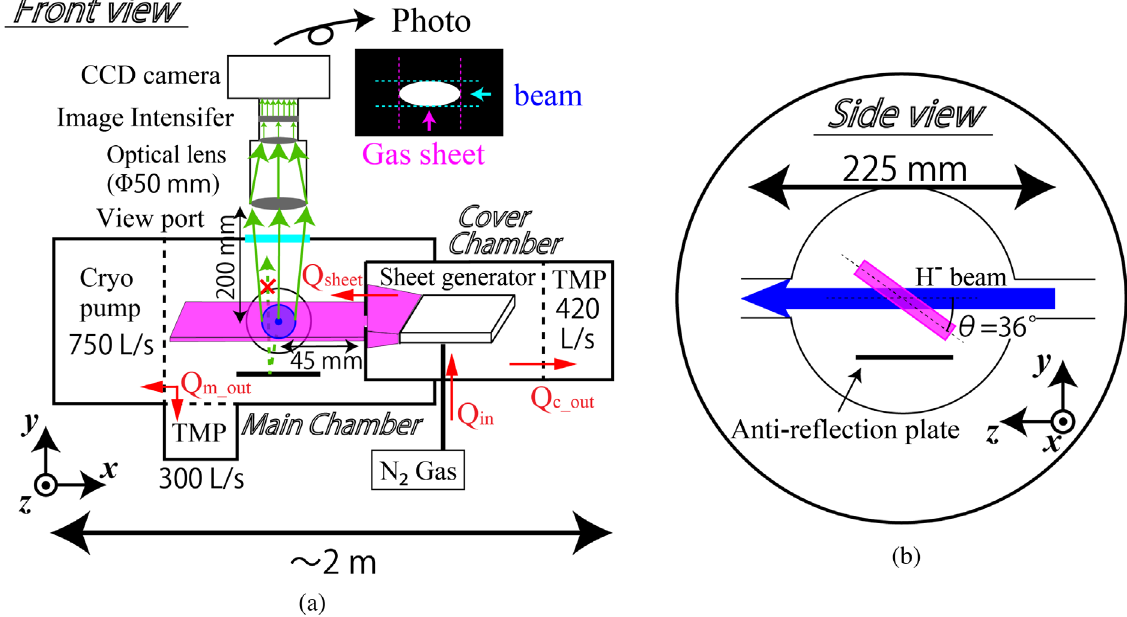
FIG. 7. The gas sheet monitor system: (a) the front view and (b) the side view. The system consists of a main chamber connected to a beam line, a gas sheet generator attached to a cover chamber that consists of a 0 . 5 mm × 50 mm slit and a TMP, two vacuum pumps, and a photon detector system consisting of optical lenses, an image intensifier, a CCD camera, and an antireflection plate. The gas sheet tilts 36 degrees from the beam. speed against N 2 of 750 and 300 l = s, respectively. Figure 9 indicates the gas pressures at the main chamber, the pressure at the RFQ, the flux of the gas sheet Q , and sheet the introduced gas flux to the generator Q as a function of in